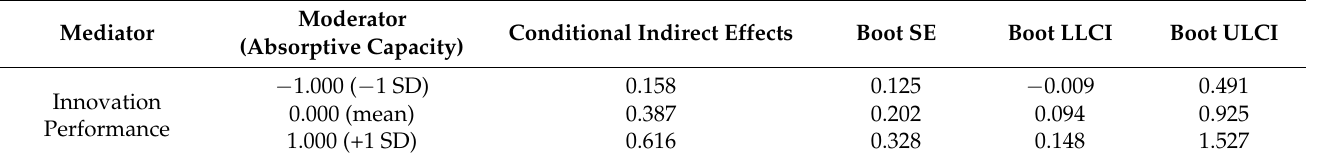
Table A3. Bootstrap significance test for conditional indirect effect of knowledge acquisition on return on sales through innovation performance at different levels of absorptive